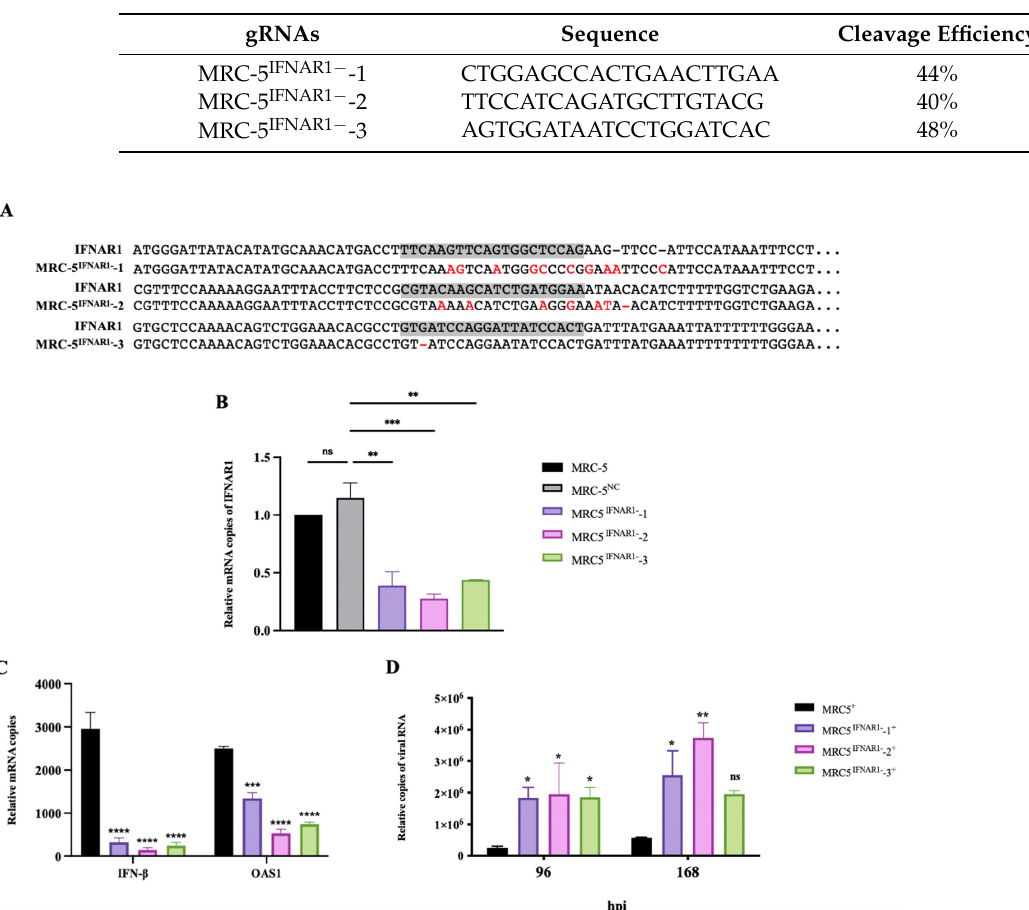
Figure 4. RABV production was enhanced in MRC-5 IFNAR1 − cells. ( A ) Genomic DNA from three MRC-5 IFNAR1 − : gRNAs cell lines was extracted. The target sequence was amplified by PCR with IF- NAR1 gRNA MRC-5 IFNAR1 − -1,2,3 primers in Table 4 and then was sequenced. The deficiency of IF- NAR1 in three MRC-5 IFNAR1 − cell lines were confirmed by sequencing trace analysis. The gRNA tar- get area is marked in gray. Mutated bases are marked in red, and—means deletion. ( B ) Three MRC-